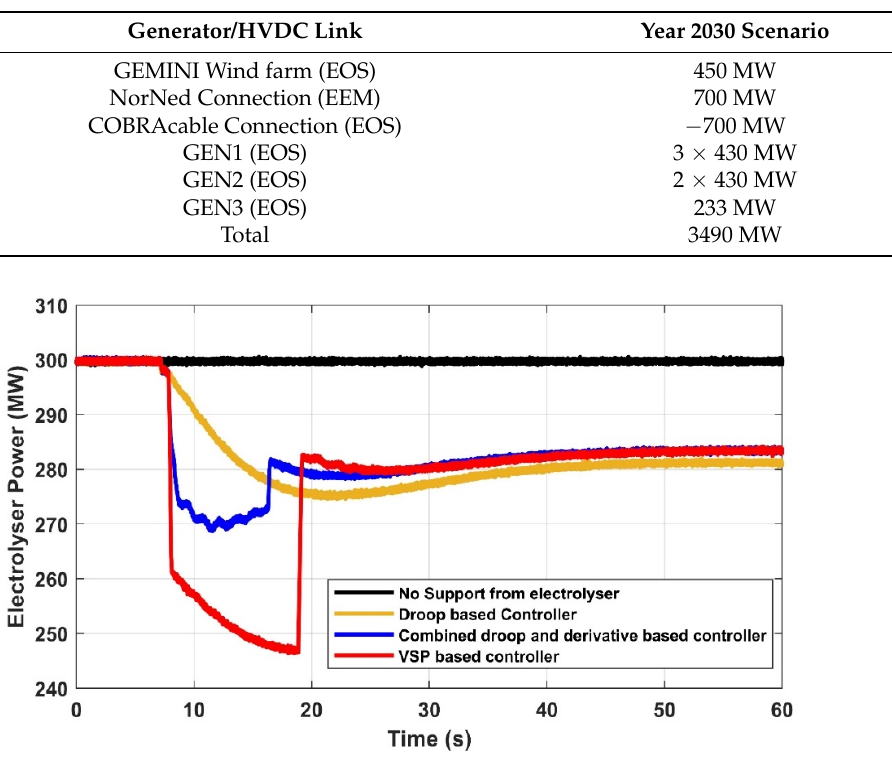
Figure 8. Shape of the power output of the PEM electrolyzer due to the action of FAPR.